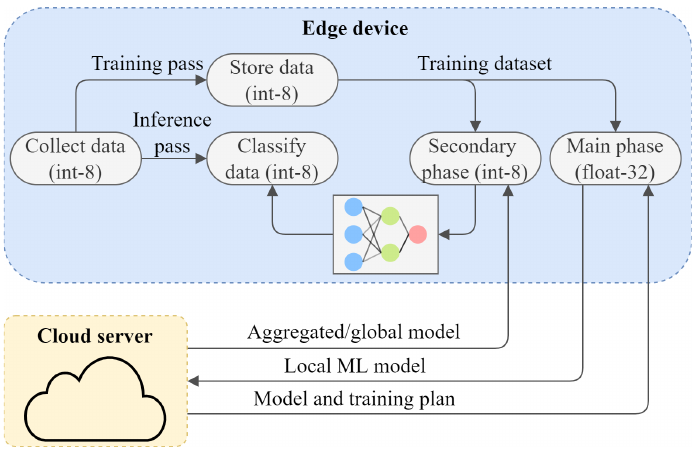
Figure 3. Hybrid training workflow.